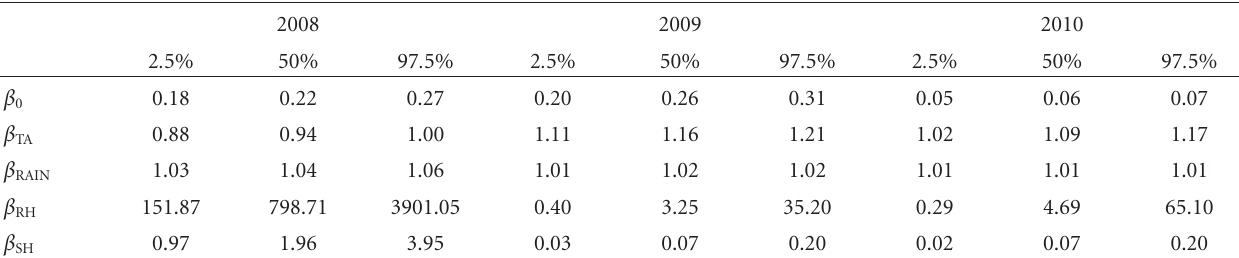
Table 4: Odds ratio and 95% interval for the autoregressive model.